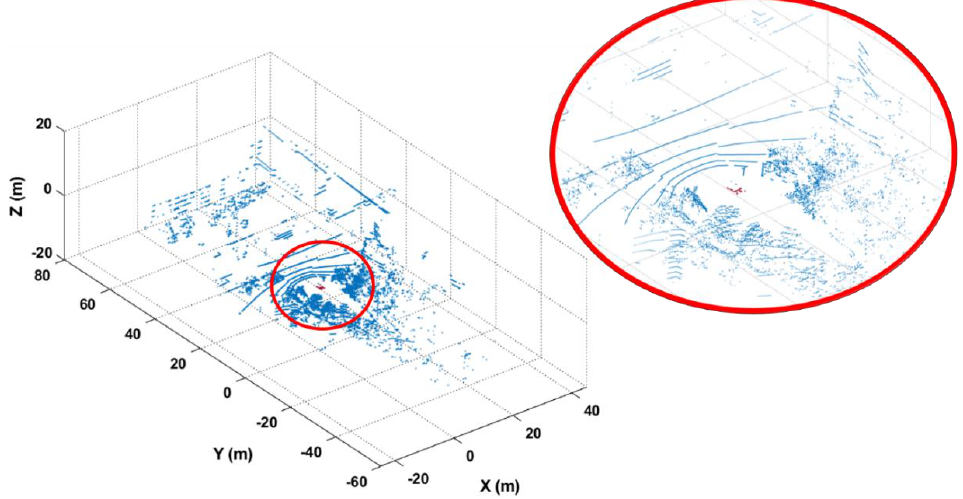
Figure 3. Ego Vehicle Points Labeled in Red in the Point Cloud.